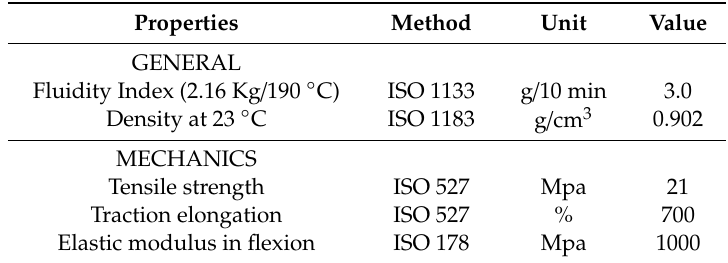
Table 2. High-density polyethylene (HDPE) features provided by